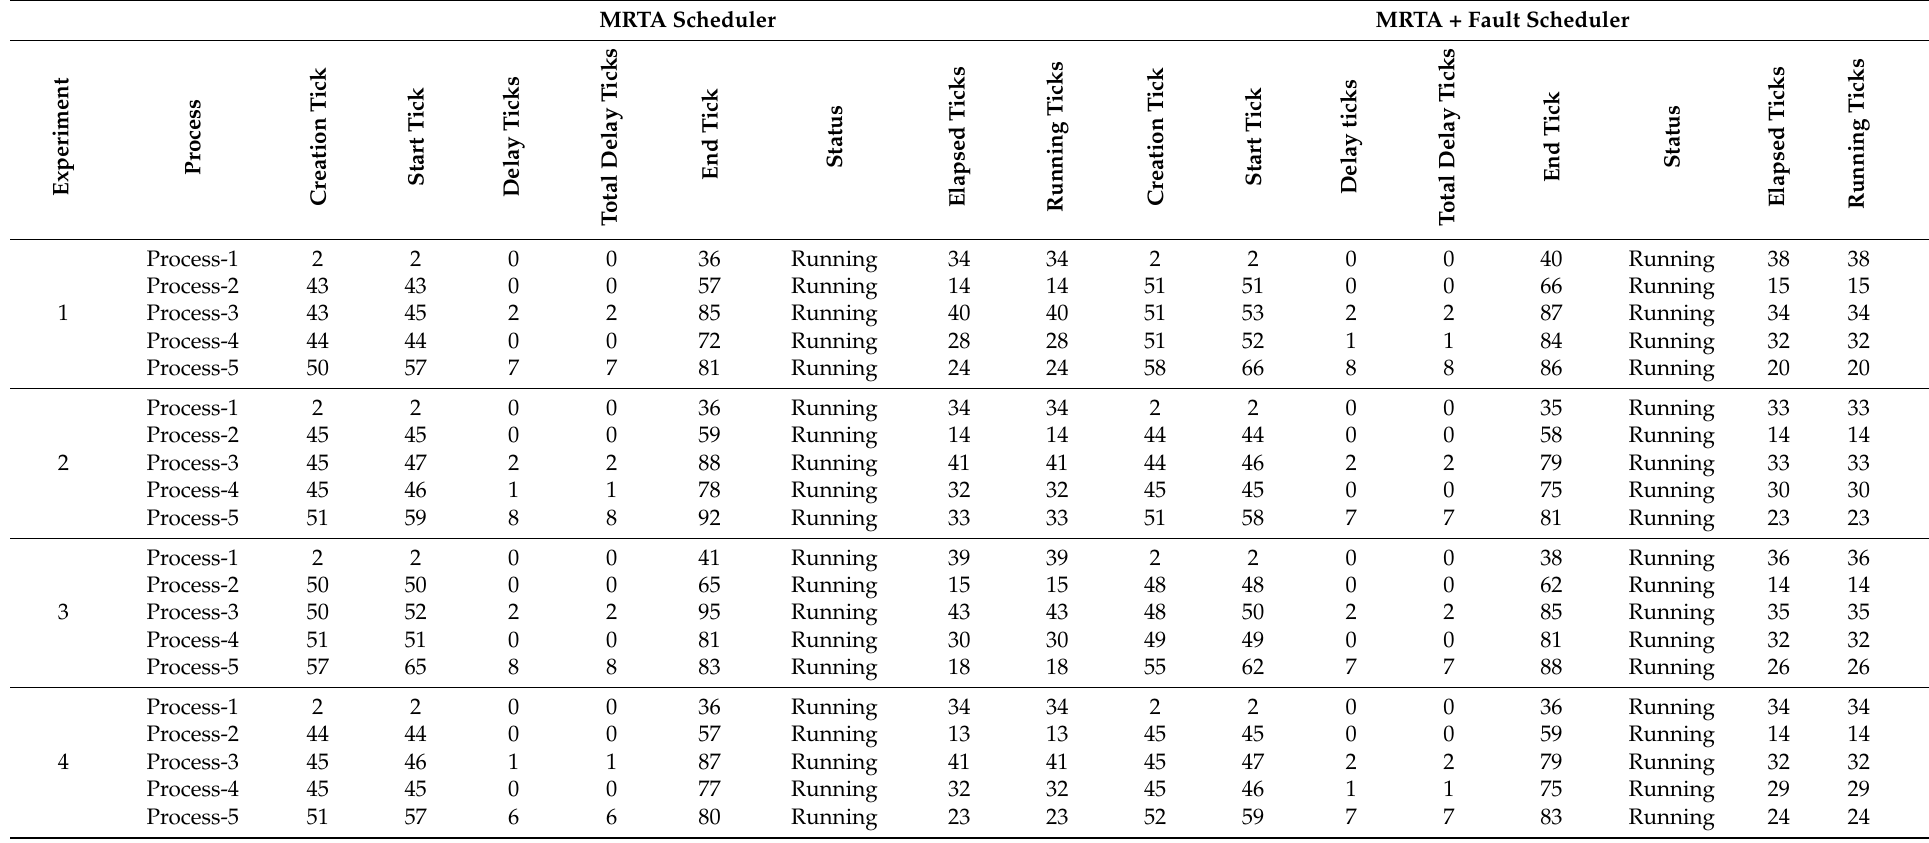
Table 5. MRTA and MRTA + Fault schedulers